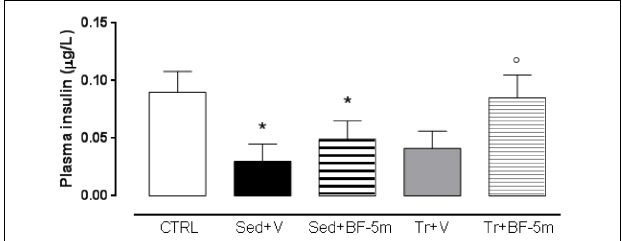
FIGURE 3 | Eight weeks plasma insulin levels in healthy control rats, sedentary diabetic rats or those subjected to a prolonged moderate exercise training. Results are reported as mean of five observations ± S.E.M. CTRL, healthy control rats; Sed+V, diabetic sedentary rats treated with vehicle; Sed+BF-5m, diabetic sedentary rats treated with BF-5m 20 mg/kg/day; Tr+V, diabetic trained rats treated with vehicle; Tr+BF-5m, diabetic trained rats treated with BF-5m 20 mg/kg/day; ∗ P < 0.05 vs. CTRL; ◦ P < 0.05 vs. the same pharmacological treatment in the sedentary